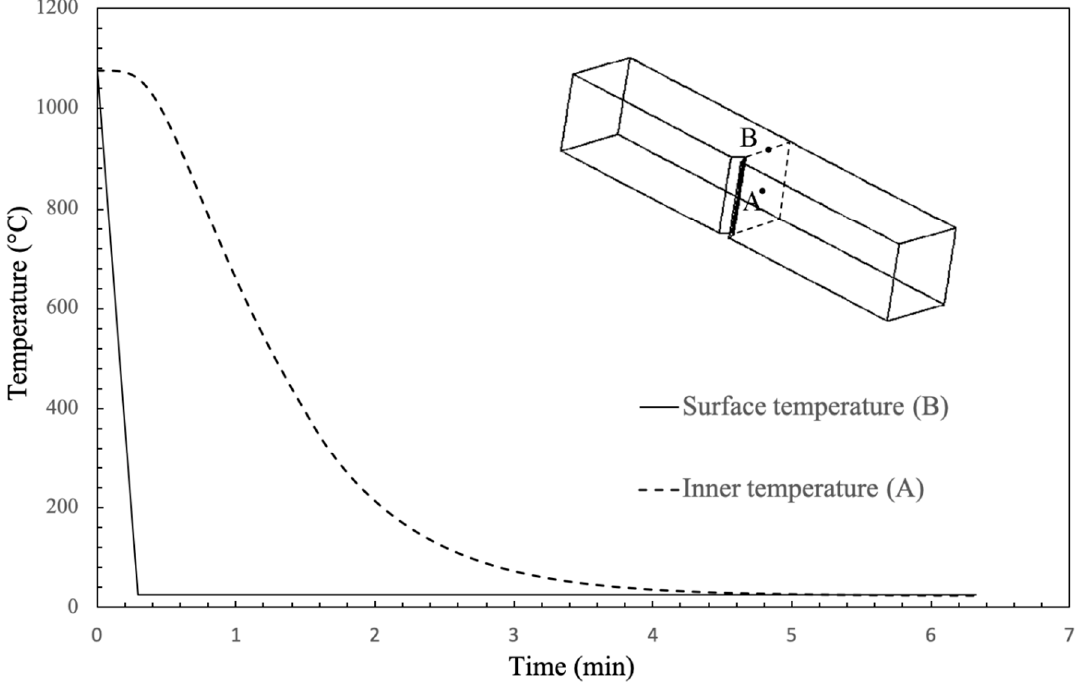
Figure 11. Calculated temperature histories at two points (A and B) of the Charpy specimen.